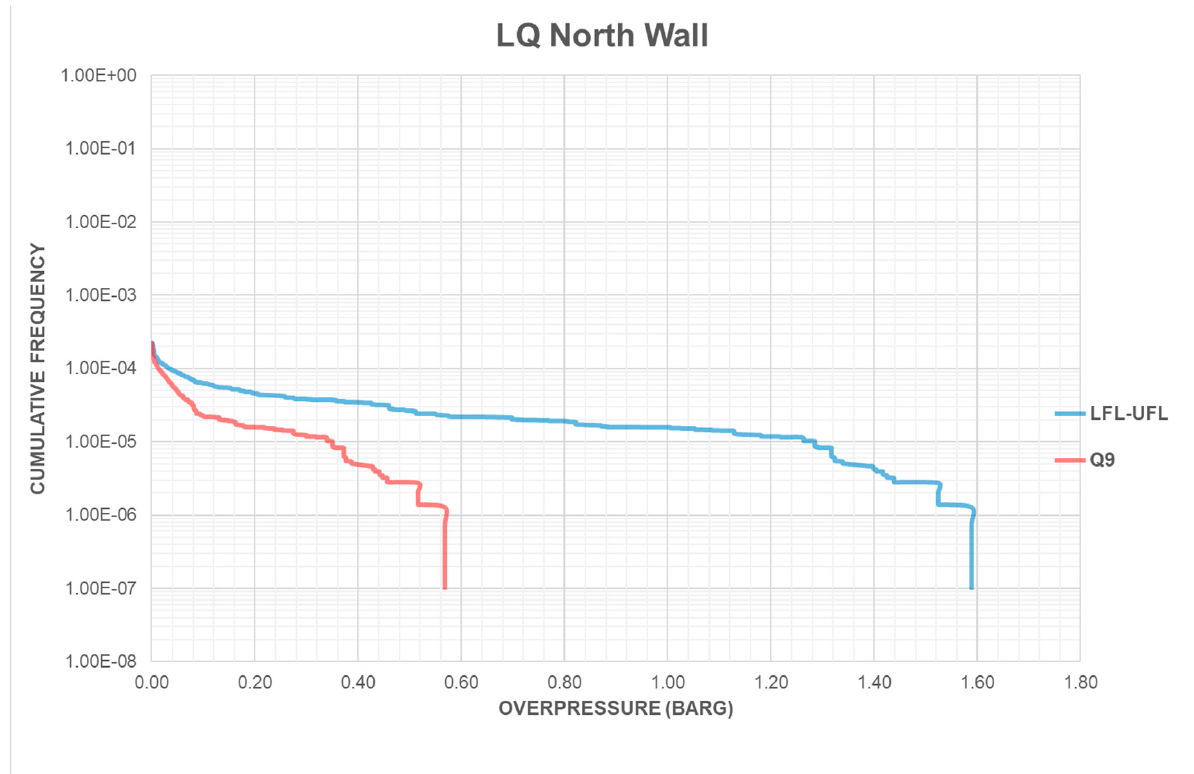
Figure 10. Exceedance curve showing cumulative frequencies for overpressures on a structural wall of a living quarter taken from A design study of an offshore production facility. These curves were derived from ESC model: Q9 and ∆ FL (concentration between upper and lower flammability limits, this is labelled as “LFL-UFL”) in the legend).